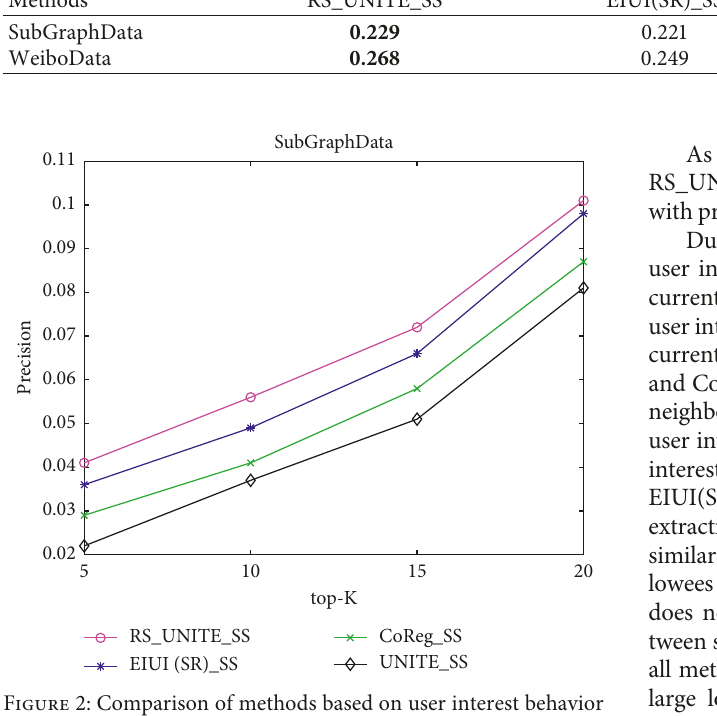
Table 7: Comparison results of MRR based on user retweeting behavior of different methods under different dataset. Methods